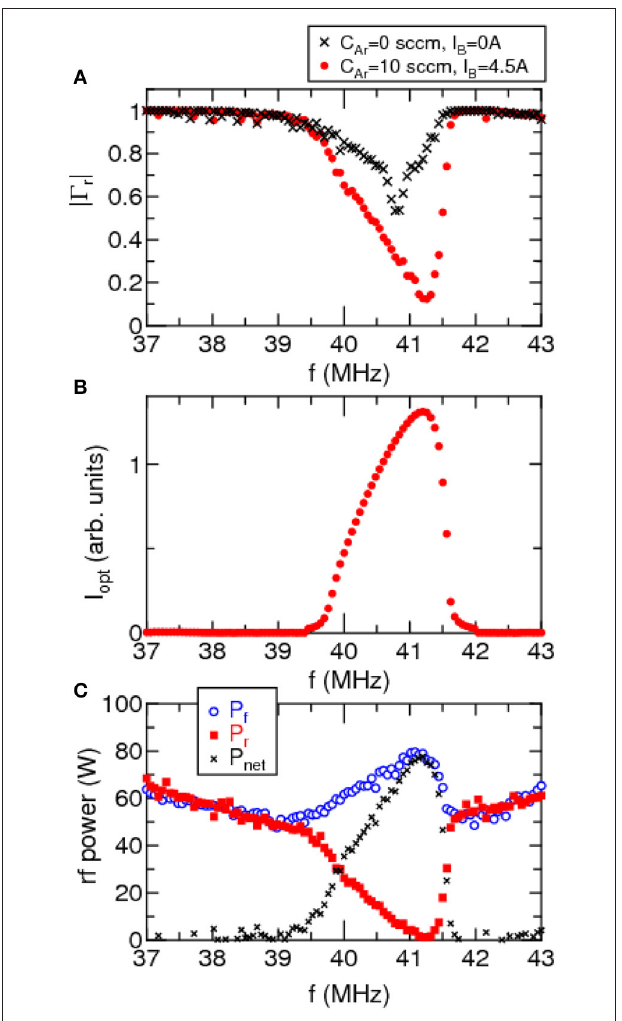
FIGURE 5 | (A) Measured reflection coefficient | Γ r | as a function of the rf frequency for C Ar 0 sccm and I B 0A case ( crosses ) and for C Ar = = sccm and I B 4.5A case ( filled circles ). (B) The optical emission intensity I opt = measured from the viewport on the upstream flange. (C) The forward ( P f , open circles ), reflected ( P r , filled squares ), and net ( P net , crosses ) rf powers.